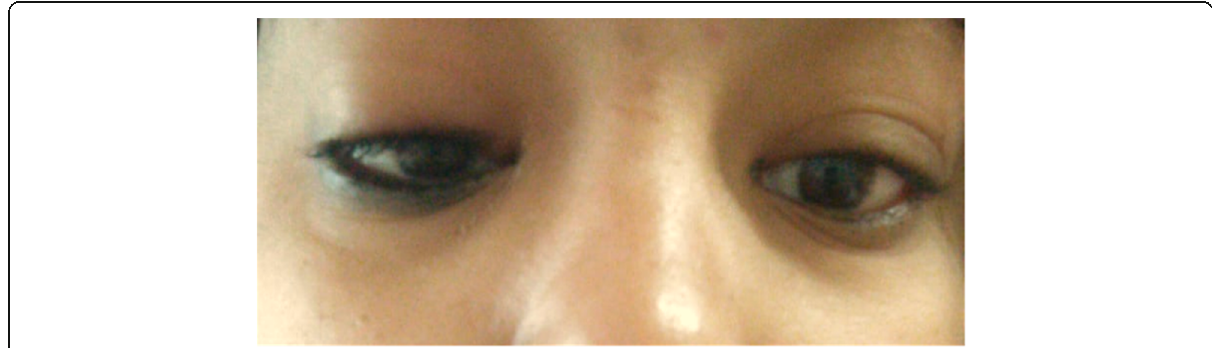
Fig. 1 View of the eye showing diffuse swelling of the upper lid of the right eye with a normal anterior segment and mild congestion in the left eye, 3 days after performing the dental